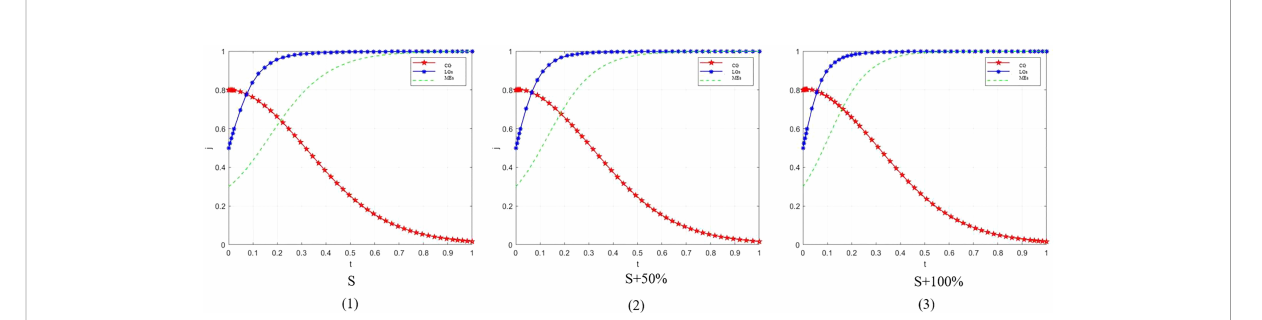
FIGURE 5 The impact of CG ’ incentives on the evolution.